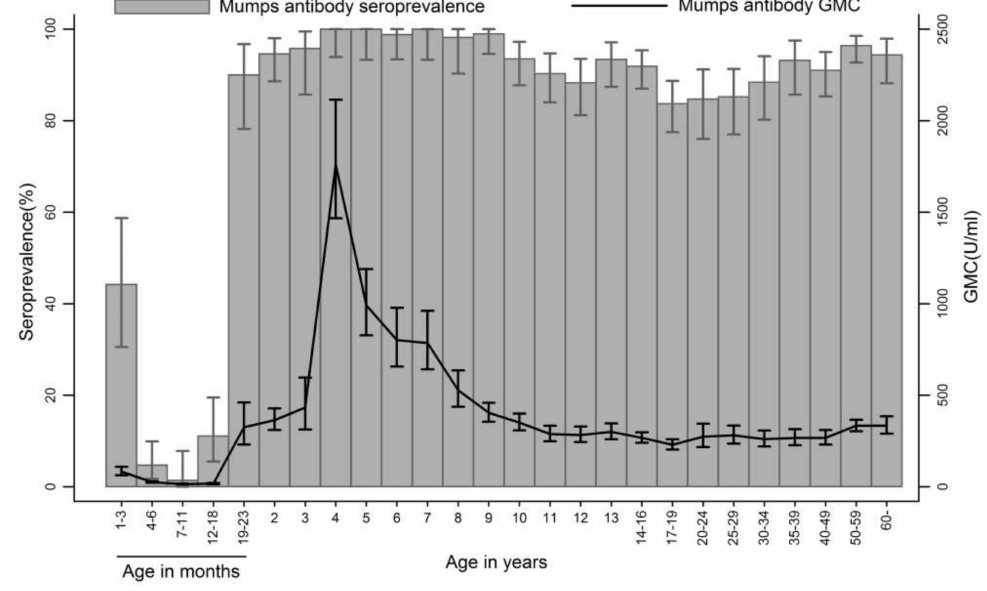
Figure 1. Age specific seroprevalence and GMC of mumps antibody. The error bars represent the 95% CI.